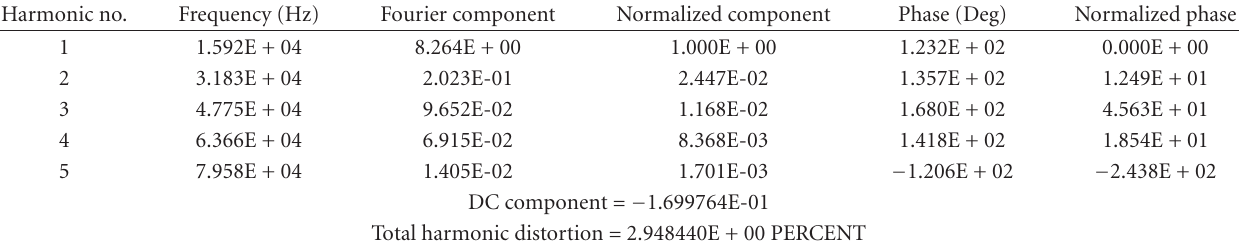
Table 1: Total harmonic distortion analysis of the proposed CDBA-based quadrature oscillator of Figure 4. Harmonic no.